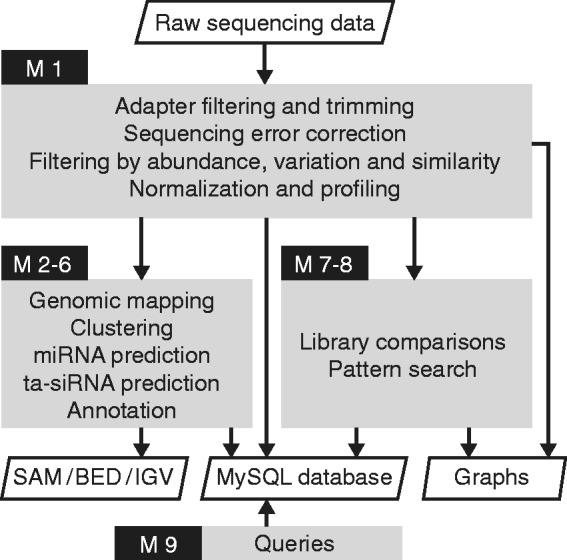
shortran flowchart